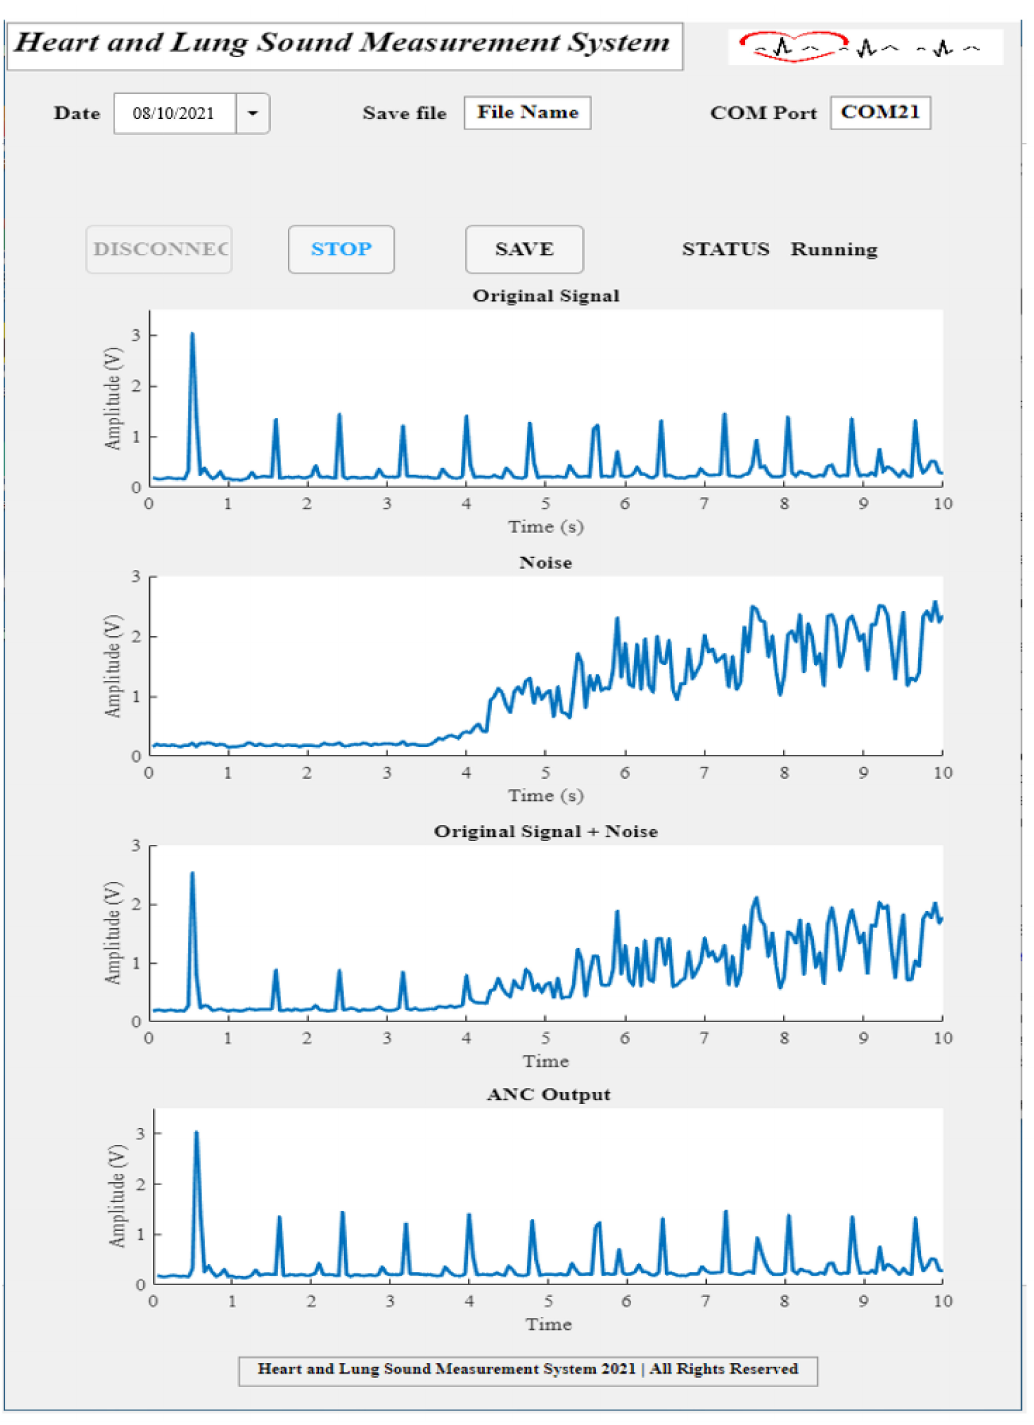
Figure 18. System experimental results displayed using the developed MATLAB